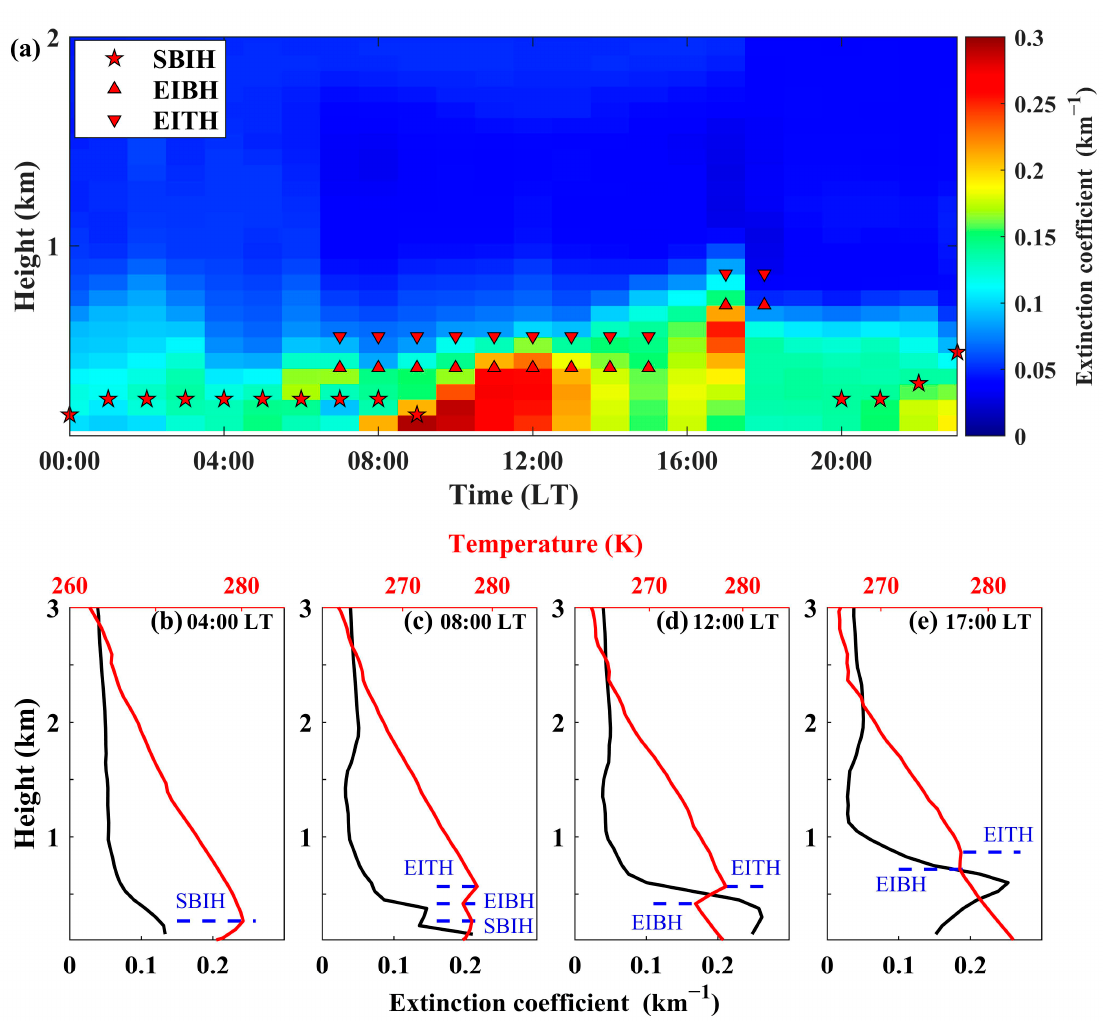
Figure 5. Case study on 27 February 2020: ( a ) time-height cross-section of extinction coefficient. Red star, red positive and inverted triangles represent surface-based inversion height, elevated temperature inversion bottom height and elevated temperature inversion top height, respectively. The vertical profile of extinction coefficient (black) and temperature profile (red) observed at ( b ) 04:00, ( c ) 08:00, ( d ) 12:00, and ( e ) 17:00 local time over the Southern Great Plains site. The blue dotted lines represent the different height layers.